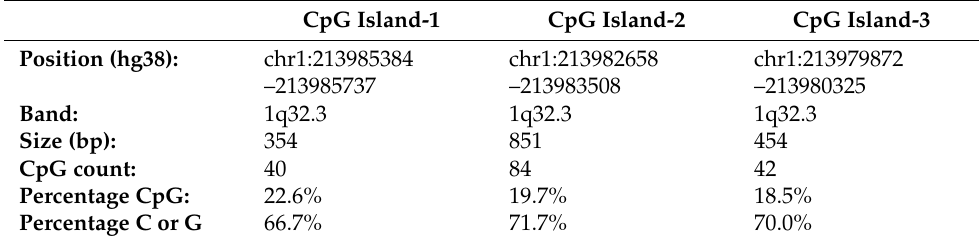
Table 4. The location and characteristics of the islands.